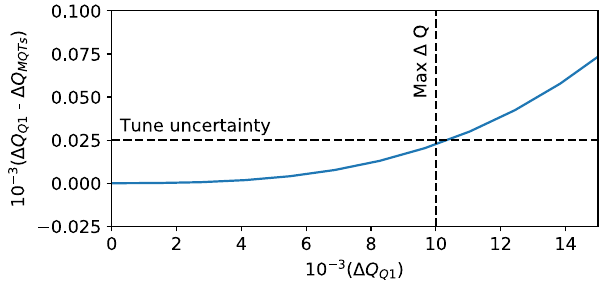
FIG. 9. Simulation of a K-modulation using the tune feedback. Here Δ Q Q 1 is the change of tune produced by the trim of the Q1 and Δ Q the change of tune produced by the arcs tuning MQT quadrupoles to compensate the Q1 effect. The horizontal line shows the tune measurement uncertainty of 2 . 5 × 10 − 5 . When the curve is above this line the cross-talk between Q1 and arcs tuning quadrupoles is dominating the error of the K-modulation meas- urement. The vertical line shows the maximum allowed change of tune in the absence of tune